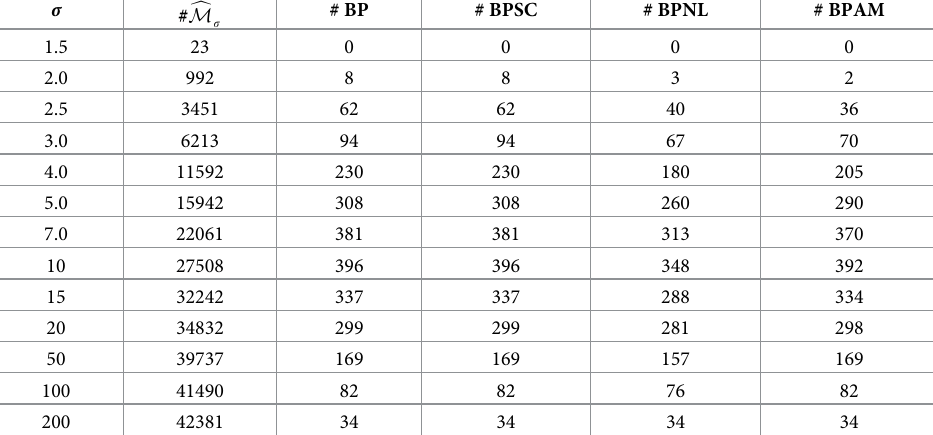
Table 2. Blinking parameter points. For each value of σ in column 1, the number of bistable points in the 4 × 10 6 sam- ples obtained by independent logarithmic random (ILR) sampling is shown in column 2 (see also Fig 3). Of these bis- table points, the number of blinking points, or those which become monostable at some larger value of σ , is shown in column 3 (titled BP). The subsequent columns indicate, for each value of σ , the number of blinking points that lie out- side the largest component in the corresponding initial connectivity graph (BPSC, column 4); the number of blinking points that never enter the largest component of the initial connectivity graph for larger values of σ (BPNL, column 5); and the number of blinking points that are monostable at σ = 500 (“asymptotically monostable”, BPAM, column 6). The numbers show that blinking points are found primarily on the boundary of the bistable region and become mono- stable for large values of σ , as discussed further in the